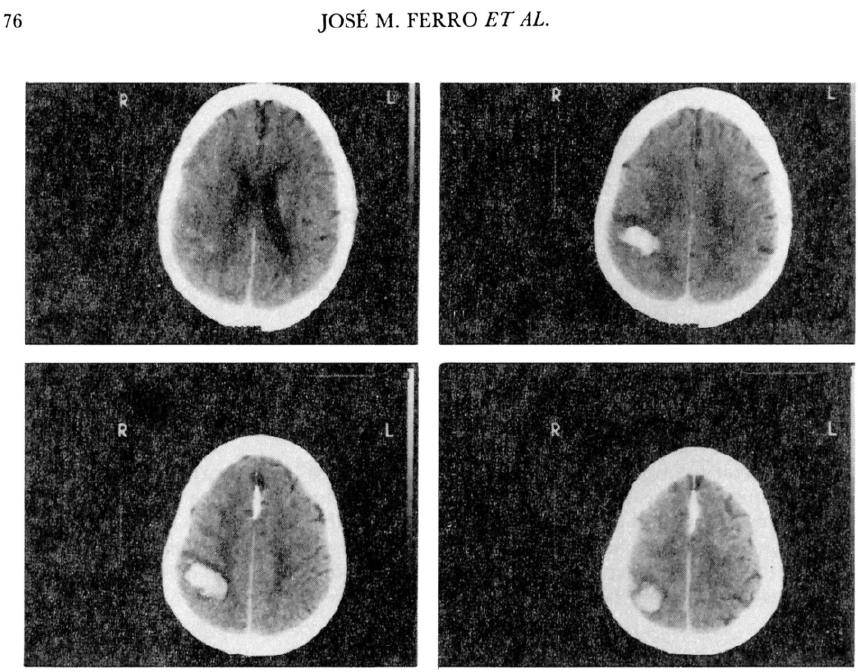
FIG. I. CT scan: right parietal haematoma, involving the white matter deep to the angular gyrus and the superior parietal